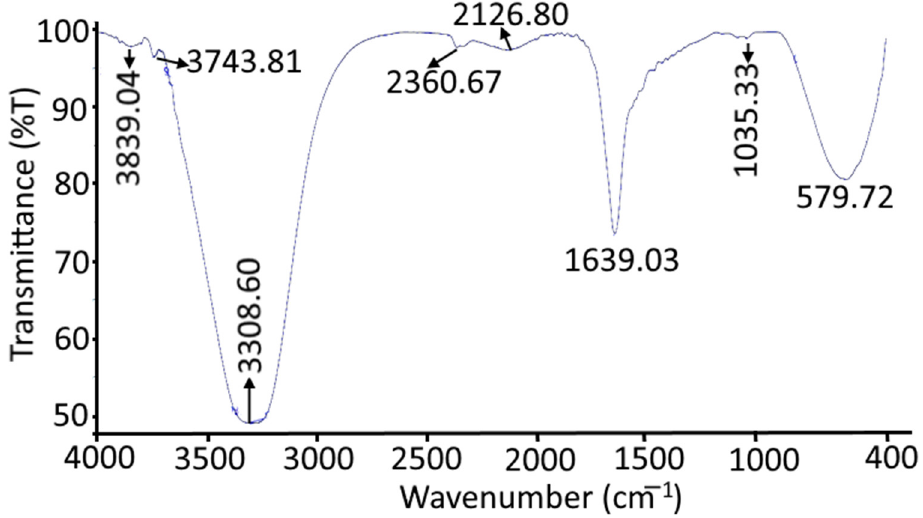
Figure 7. FTIR spectrum of Azadirachta indica oil